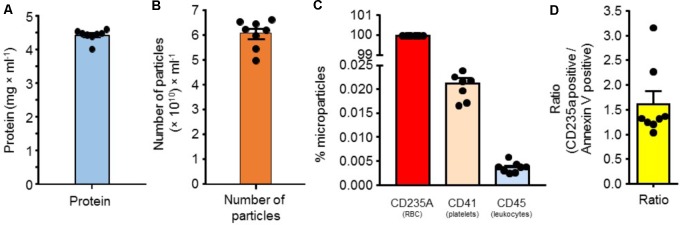
(A) Protein quantity in suspension of RMPs (n = 8). (B) Number of microparticles/mL of RMP in suspension (n = 8). (C) Percent of microparticles labeled with a marker for red blood cells, platelets, or leukocytes (n = 8). (D) CD235a positive/Annexin V positive particle distribution in RMPs (n = 8).